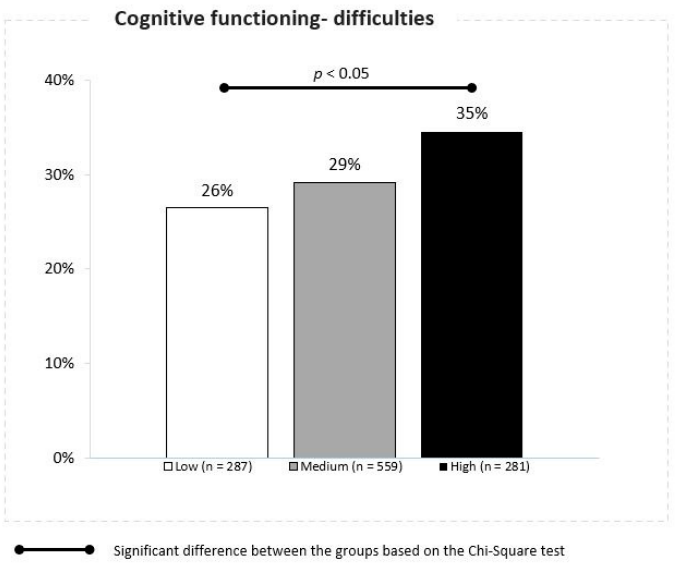
Figure 7. Association between the PM 2.5 concentrations and sneezing. With the increase in the daily mean concentration of PM2.5, difficulties in cognitive functioning among children were observed. Disturbed cognitive functioning was reported in 26%, 29% and 35% of children living in the conditions of low, moderate and high daily mean PM2.5 concentrations, respectively (Z proportion tests, p ≤ 0.05) (Figure 8). Prevalence of outcomes long-term lagged mean of PM2.5 and PM10 have been presented on the summary graph (Figure 9).